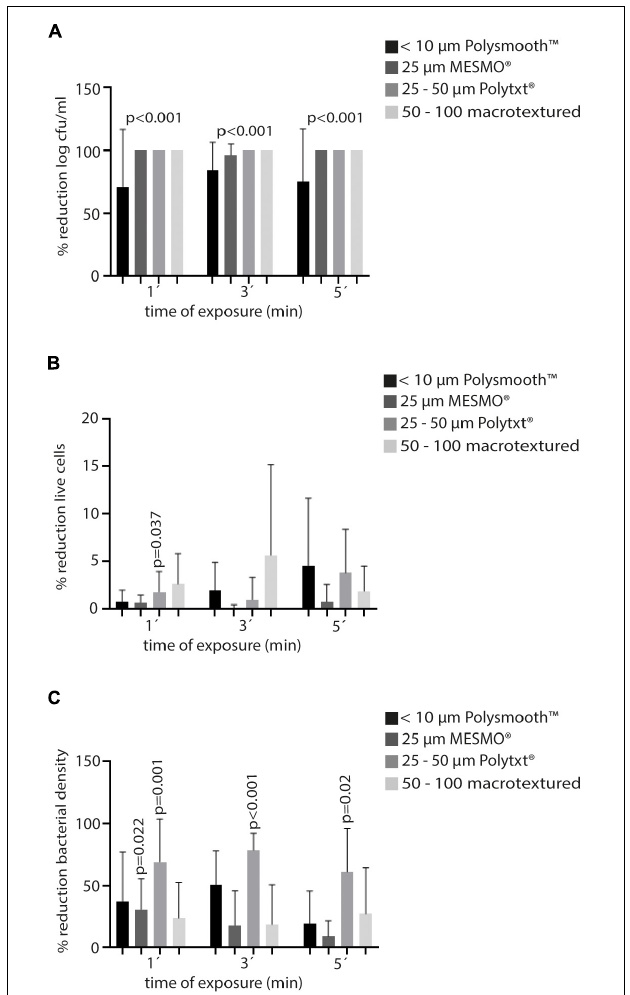
FIGURE 5 | Efficacy of PI in Polytech R (cid:13) at the three times of exposure (1 (cid:48) , 3 (cid:48) , and (cid:48) ) in terms of mean percentage reduction of the variables of all Staphylococci. (A) Log cfu/ml. (B) Live cells. (C) Bacterial density. PI, povidone iodine; cfu, colony forming